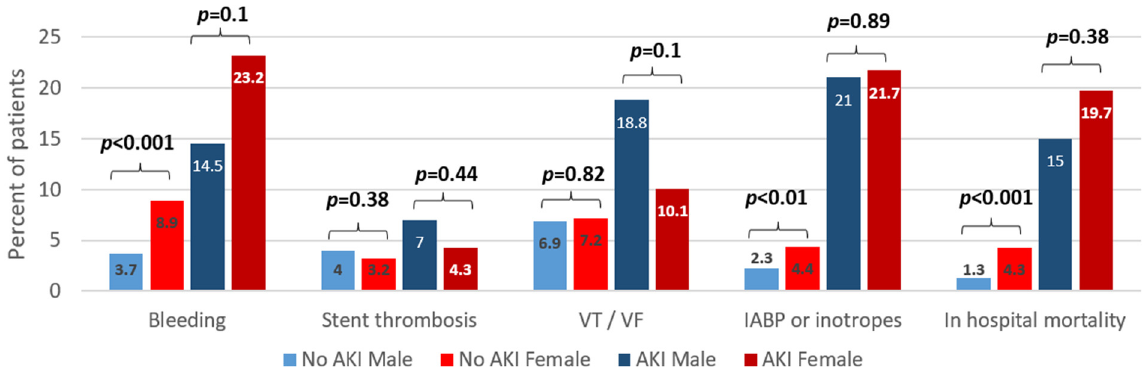
Figure 1. In-hospital adverse outcomes divided by AKI status and compared between genders. VT, ventricular tachycardia; VF, ventricular fibrillation; IABP, intra-aortic balloon pump.